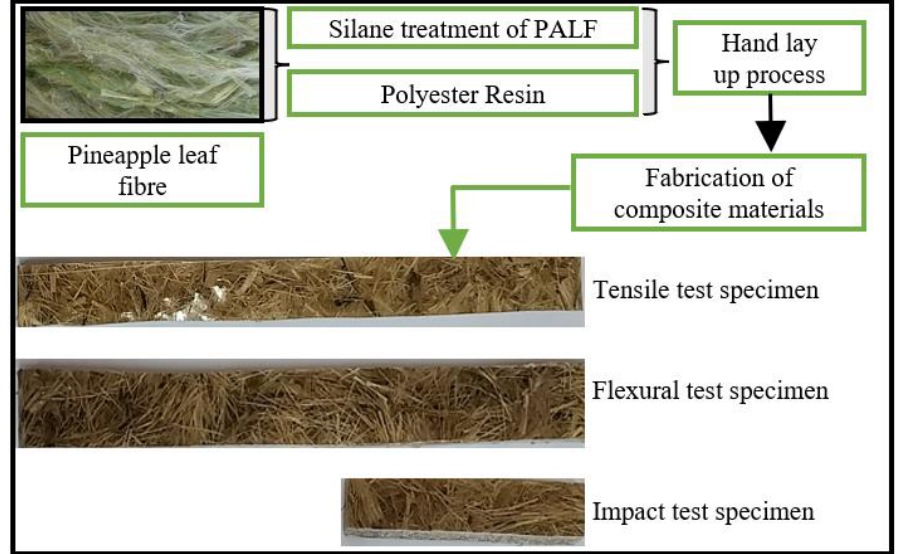
Figure 3. Methodology employed to prepare pineapple leaf fiber composites and test samples.